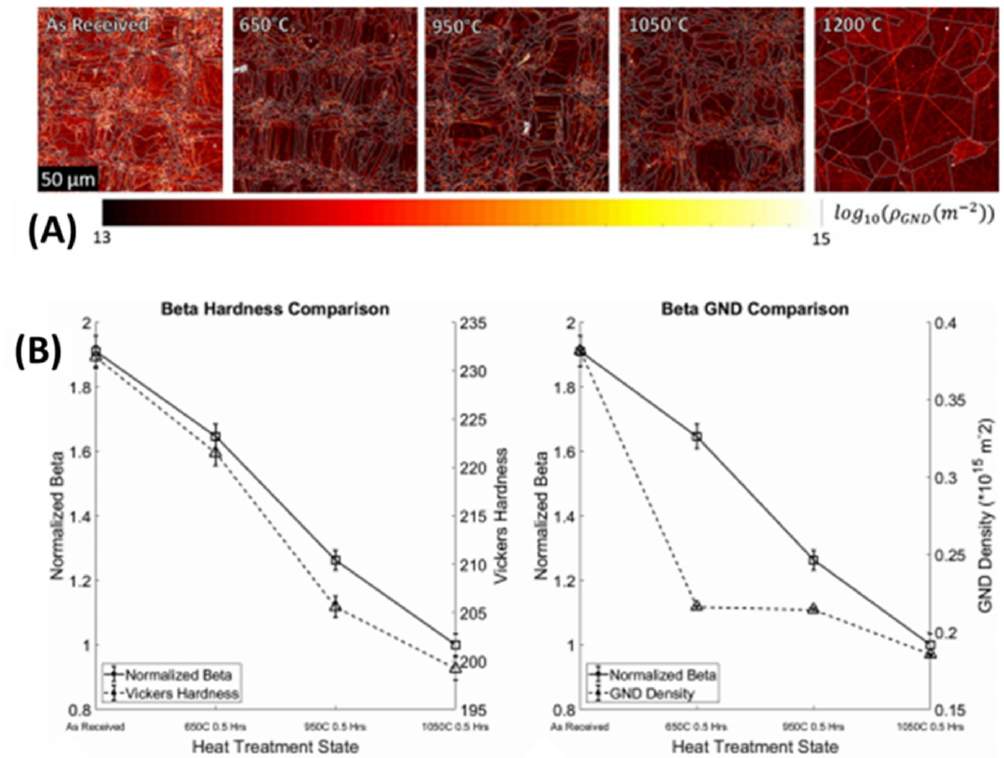
Figure 23. ( A ) The intentionally modified grain size of AM steel samples. ( B ) Experimental measurement of nonlinearity factor β versus different grain sizes from varying heat treatment